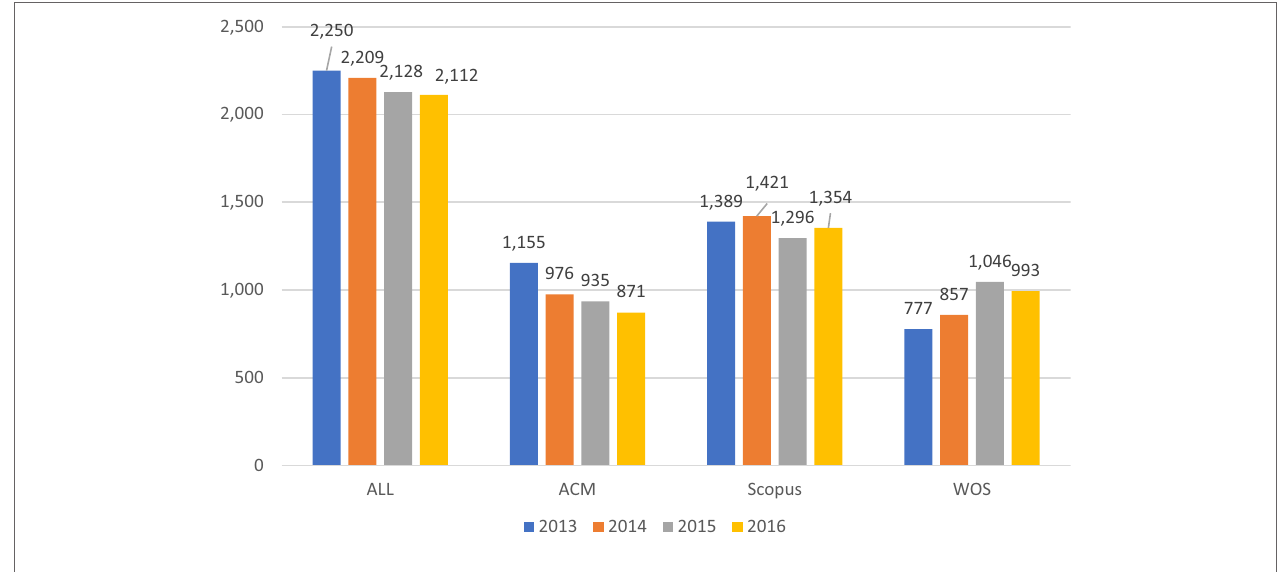
FiGurE 1 | Number of publication per year and per